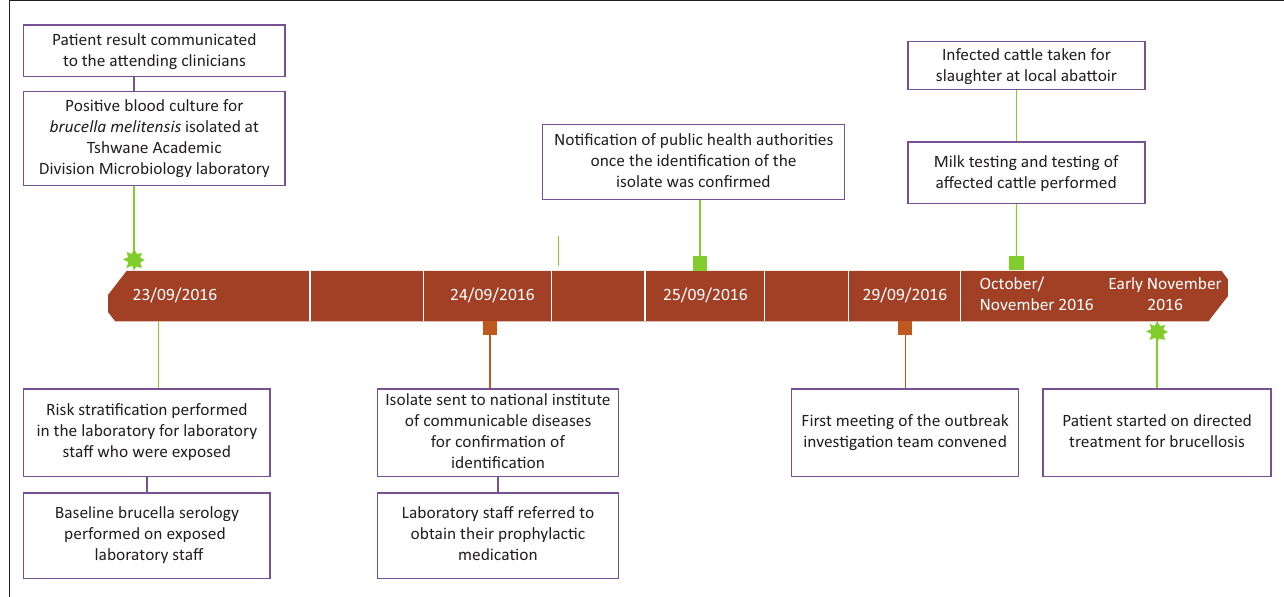
FIGURE 1: Significant timelines in the series of events related to the brucellosis case at Steve Biko hospital (Pretoria, South Africa) from September to November